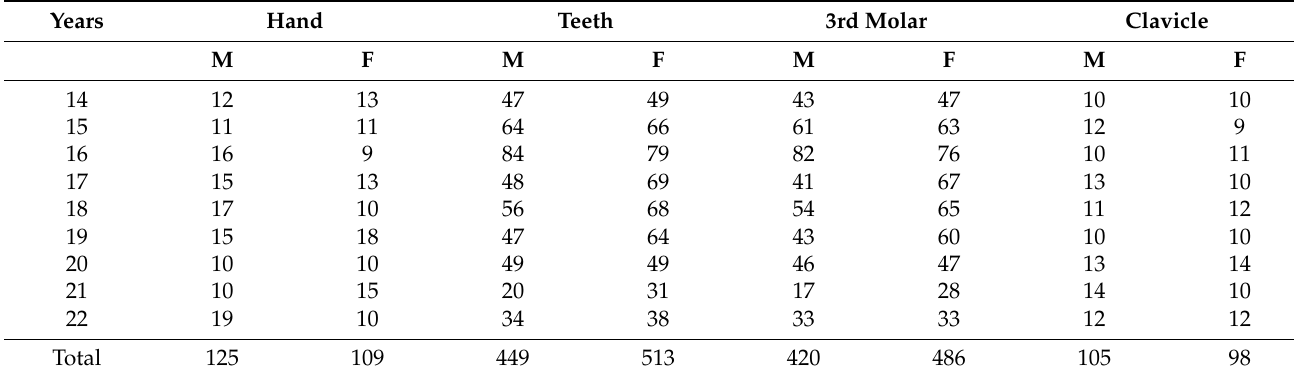
Table 1. Sample distribution according to age, sex, and anatomical